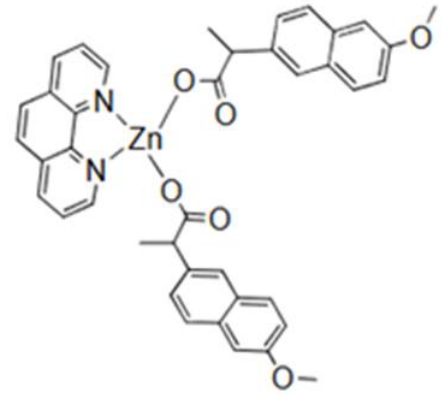
Figure 7. Zinc naproxen complex exhibiting strong anti-gram-positive and anti-gram-negative bacteria properties [60].